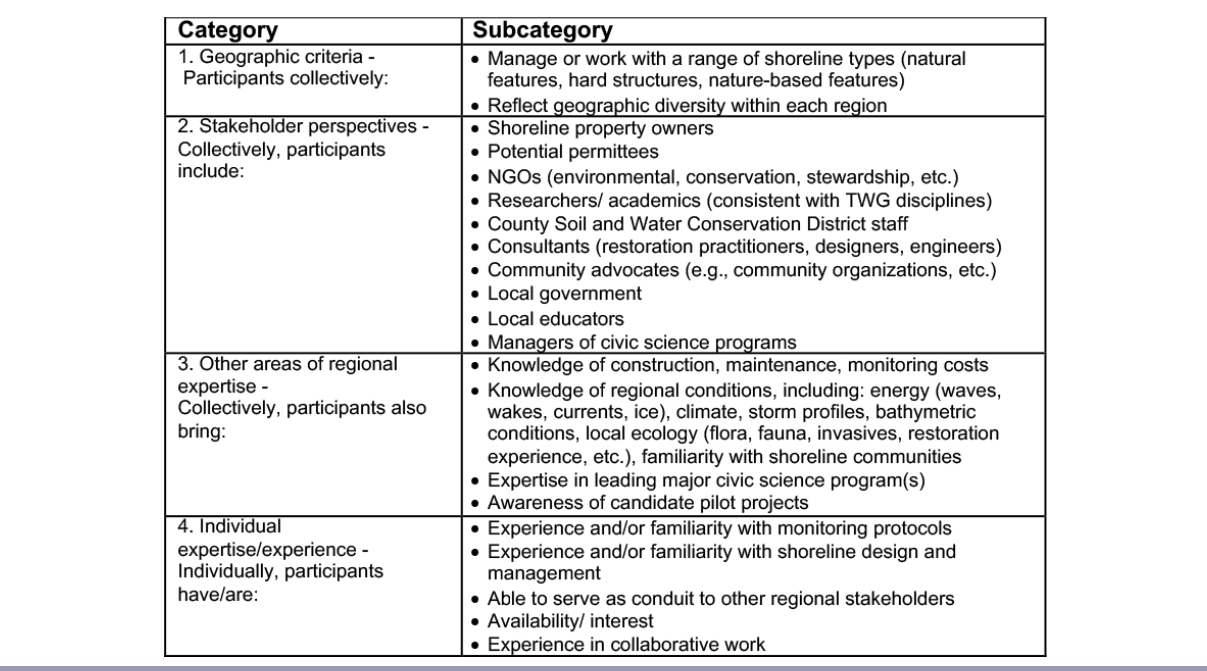
Fig. 4 . Recruitment criteria for regional working groups used to identify and engage regional working group participants within each New York State coastal region. TWG = technical working